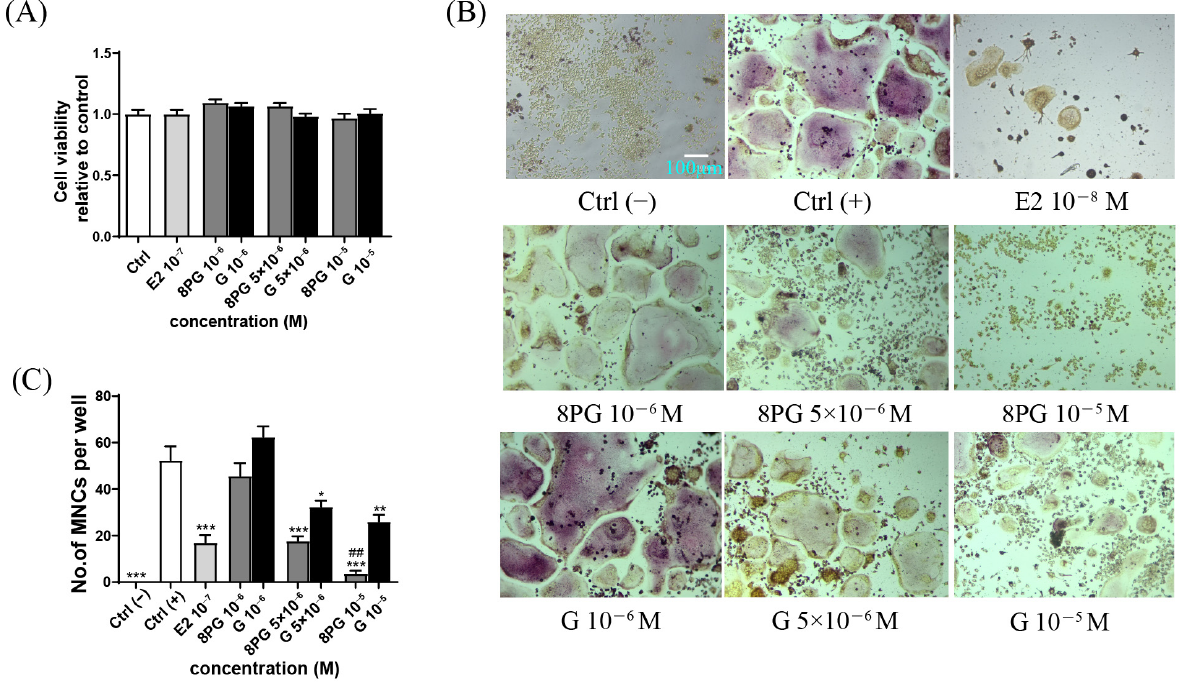
Figure 4. The effects of 8PG and genistein (G) on morphological changes in TRAP-positive RAW264.7 cells induced by RANKL for 4 days. ( A ) Evaluation of the cytotoxic effects of 8PG and G in RAW 264.7 pre-osteoclastic cells without RANKL induced by CCK-8 assay. ( B ) TRAP staining photographs captured under light microscope. C ( − ) represents control group was treated with only 1% ethanol; C (+) represents control group in which cells were induced with 1% ethanol, 100 ng/mL RANKL and 30 ng/mL M-CSF; scale bars: 200 μ m. ( C ) Number of TRAP-positive multi-nucleated cells (MNCs) were counted as osteoclast cells (> 3 nucleus); E2: 10 − 8 M, 17- β estradiol, as a positive control; data are means ± SEM (n = 3). * p < 0.05, ** p <0.01, *** p < 0.001 versus C (+); ## p < 0.01 vs. genistein (G)-treated group at the same tested concentrations.